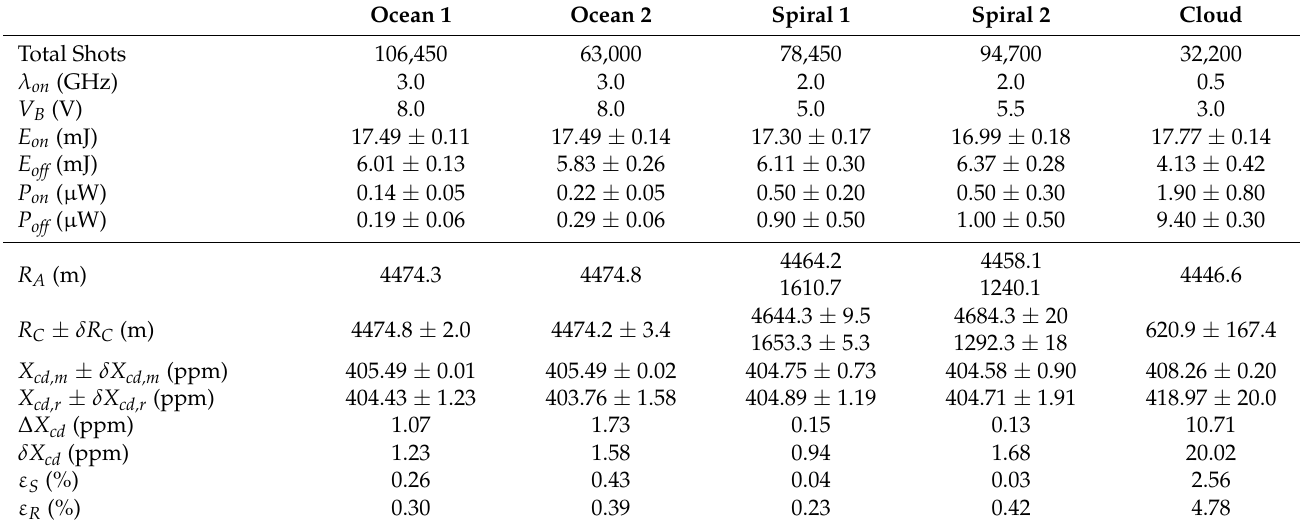
Figure 13. Airborne pulsed 2 mm IPDA lidar color diagram for range corrected off-line signals, using the e-APD detection channel set at 3 V bias voltage. Color legend represents signal strength in logarithmic scale. Signal processing included pulse synchronization, back ground subtraction, energy normalization and 1-s (50 shots) average. Vertical axis represent the range, spanning sea-level to flight altitude of 4.4 km, with 0.15 m resolution. Thick cloud cover prevents measurements from ground targets, except for some broken cloud events. Table 2. Summary for the 2- µ m CO2 IPDA lidar settings and measurement statistics for different airborne records conducted on 17 September 2019.